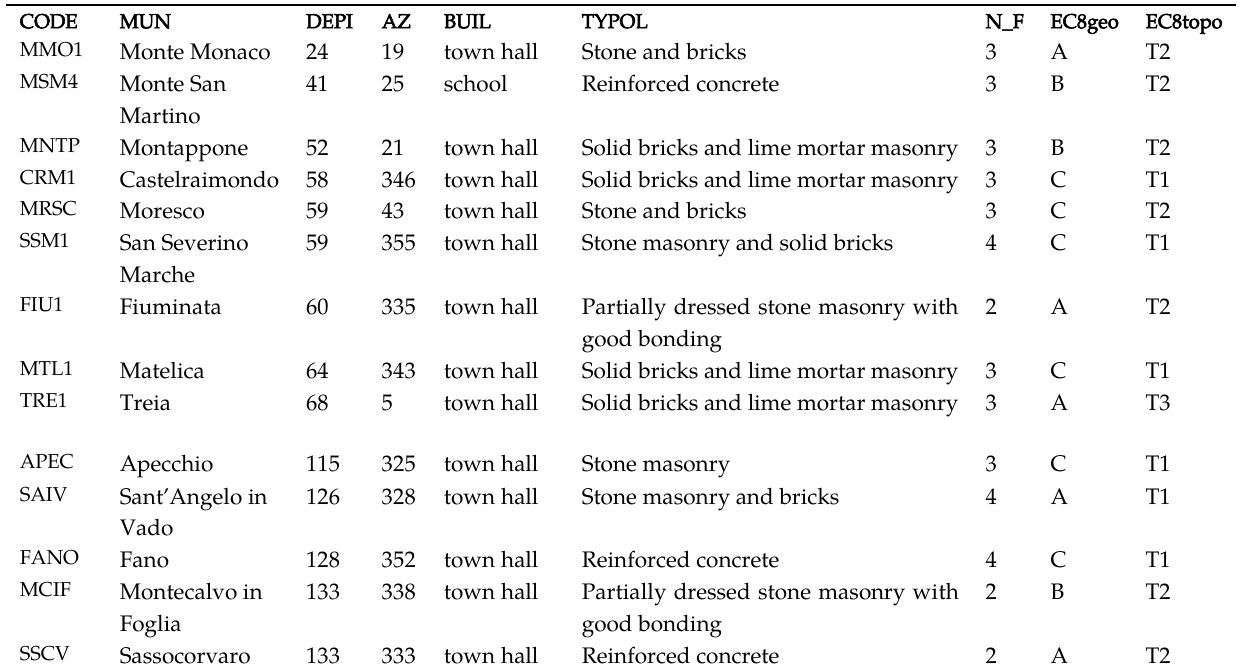
Table 1: Abbreviations, coordinates and technical characteristics of sites. Station Code (CODE), Municipality (MUN), Epicentral Distance (DEPI, km), Epicenter/station azimuth (AZ, degrees from N), Building type (BUIL), Typology of building (TYPOL), Number of floors (N_F), Soil (EC8geol) and morphological (EC8topo) categories. Information about buildings from Holistic project.